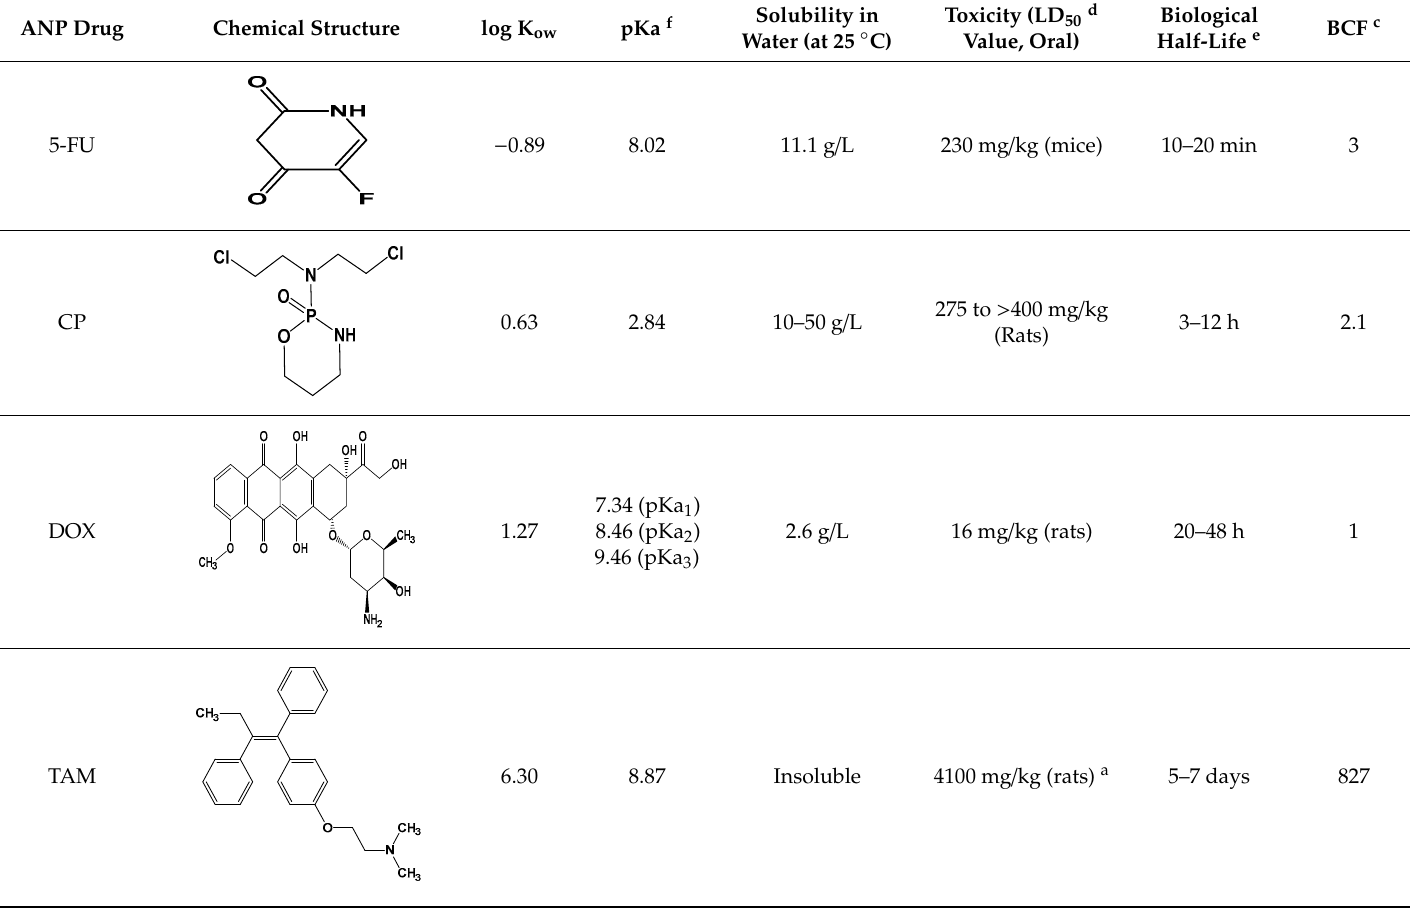
Table 1. Physico-chemical properties and ecotoxicological data of common ANP drugs.